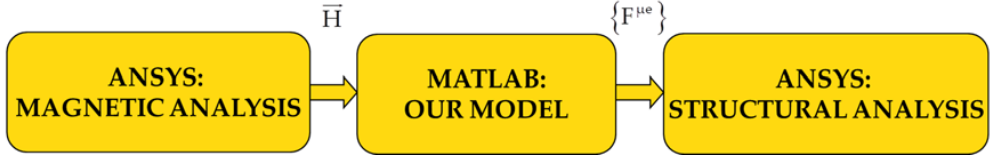
Figure 6. Forward coupling used to compute the magnetostriction strain of the test bench.